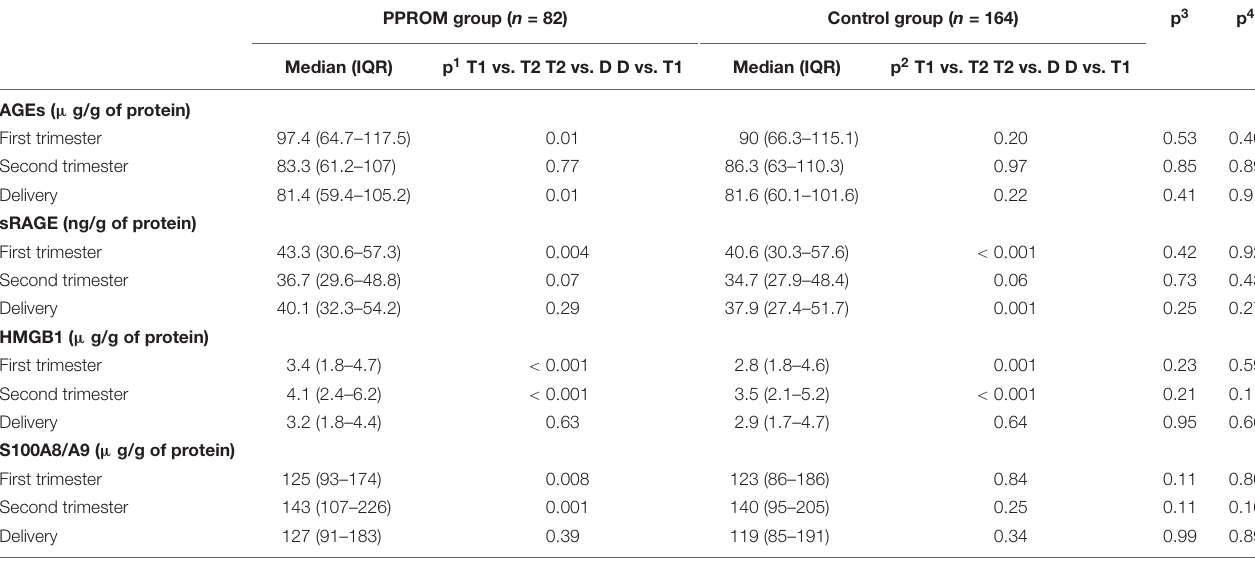
TABLE 3 | Median AGEs, sRAGE, HMGB1, and S100A8/A9 serum-extracted extracellular vesicle concentrations from 82 women in the PPROM group and 164 women in the control group at three points: first trimester (T1), second trimester (T2), and delivery (D). PPROM group ( n =